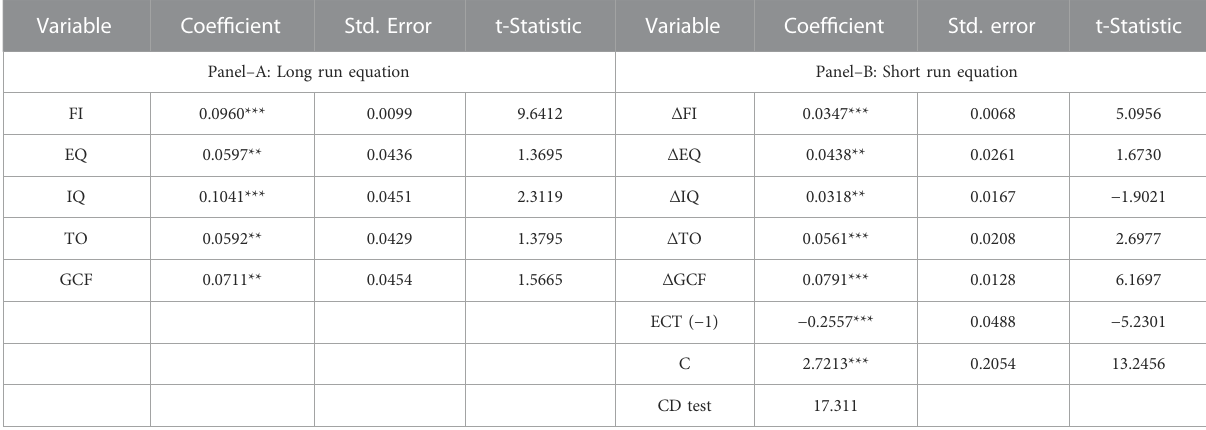
TABLE 7 Results of CS-ARDL estimation. Variable Coef fi cient Std.